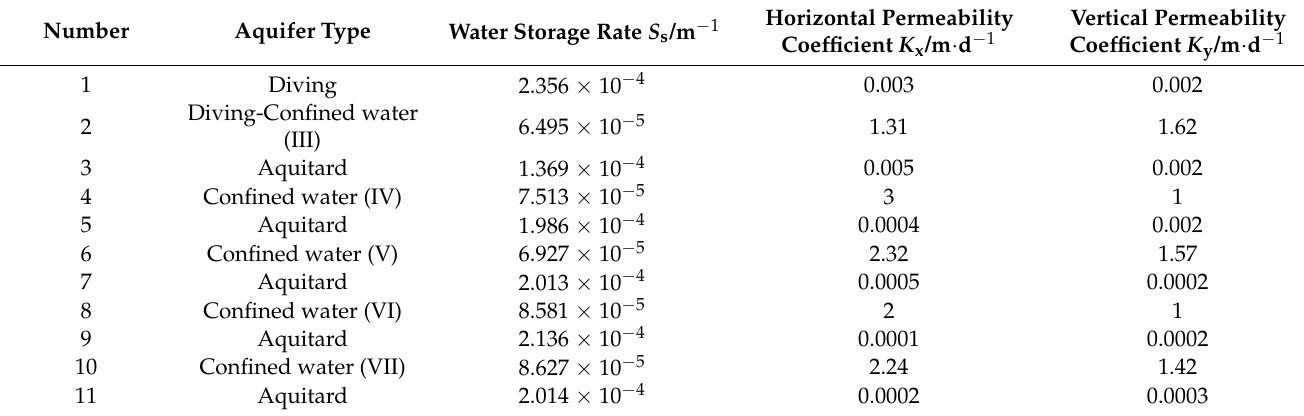
Table 6. Calculating model main geotechnical parameters table.